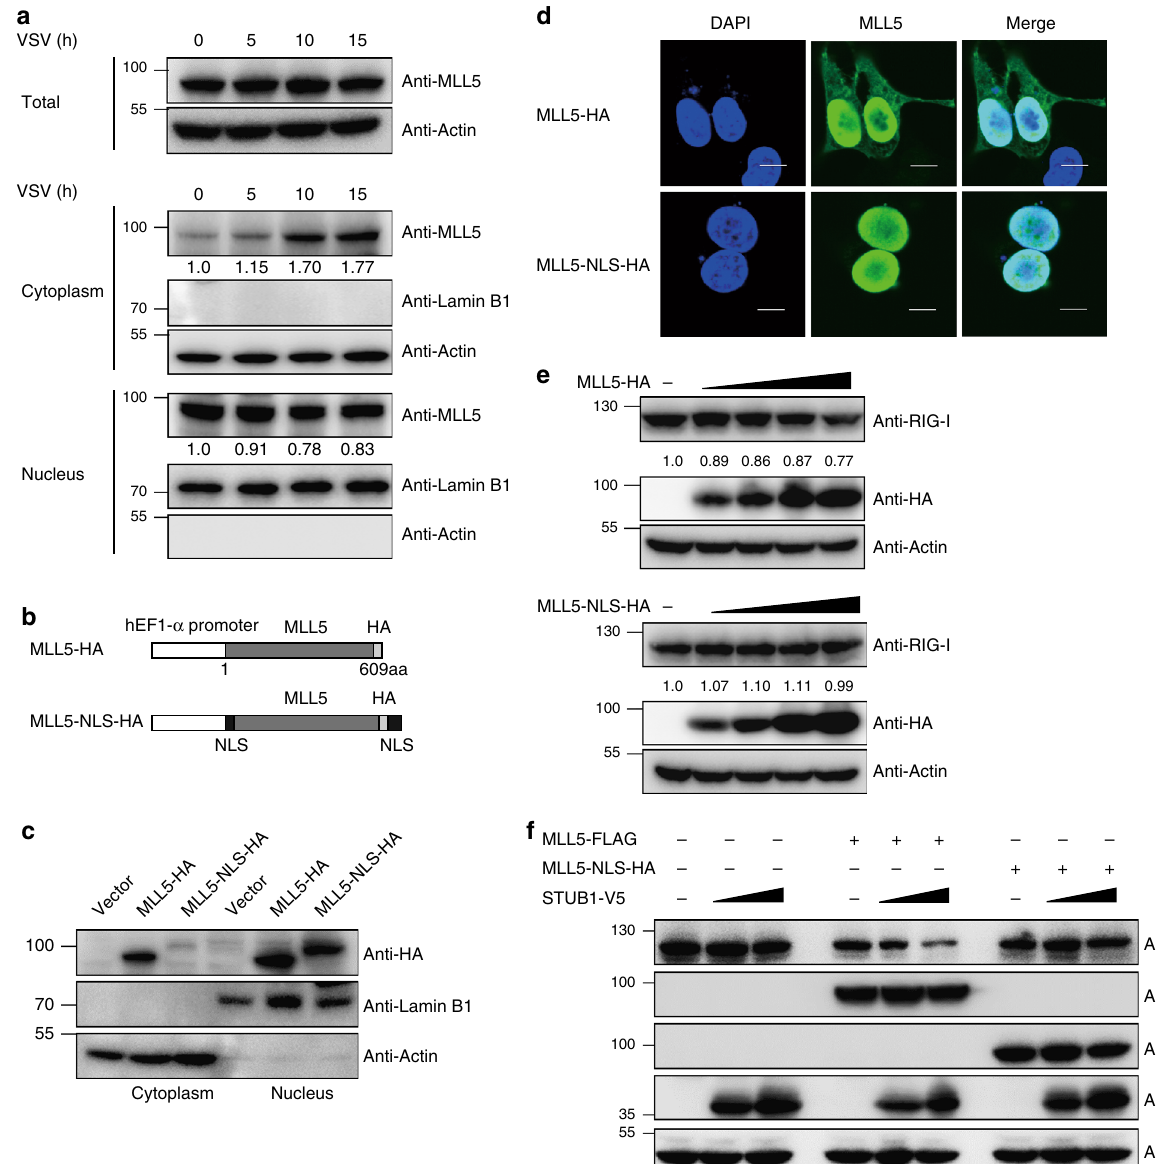
Fig. 7 Cytoplasmic MLL5 is crucial for degradation of RIG-I. a Immunoblot analysis of MLL5 in total or in the nuclear and cytoplasmic fractions in WT HEK293T cells infected with VSV-GFP (MOI:1). Actin served as a cytoplasmic control. Lamin B1 served as a nuclear protein control. Relative band densities indicating protein levels are shown blown each band. Band density indicating protein amount was quanti fi ed using Image J software. b Schematic representation of MLL5-NLS-HA with NLS signals at N and C terminals. c Immunoblot analysis of MLL5 in the nuclear and cytoplasmic fractions in HEK293T cells transfected with MLL5-HA or MLL5-NLS-HA vectors. Actin served as a cytoplasmic control. Lamin B1 served as a nuclear protein control. d Confocal microscopy images of HEK293T cells transfected with MLL5-HA or MLL5-NLS-HA plasmids. Scale bar, 10 μ m. e Immunoblot analysis of RIG-I in MLL5 − / − HEK293T cells transfected with different amount of MLL5-HA or MLL5-NLS-HA plasmids (0, 300, 600, 1000, and 2000 ng). Actin served as a loading control. Relative band densities indicating protein levels are shown below each band. Band density indicating protein amount was quanti fi ed using Image J software. f Immunoblot analysis of RIG-I in MLL5 − / − HEK293T cells transfected with empty vector, MLL5-FLAG plasmids or MLL5-NLS-HA plasmids, with STUB1-V5 plasmids (0, 400, and 1000 ng). Actin served as a loading control. Data are representative of three independent